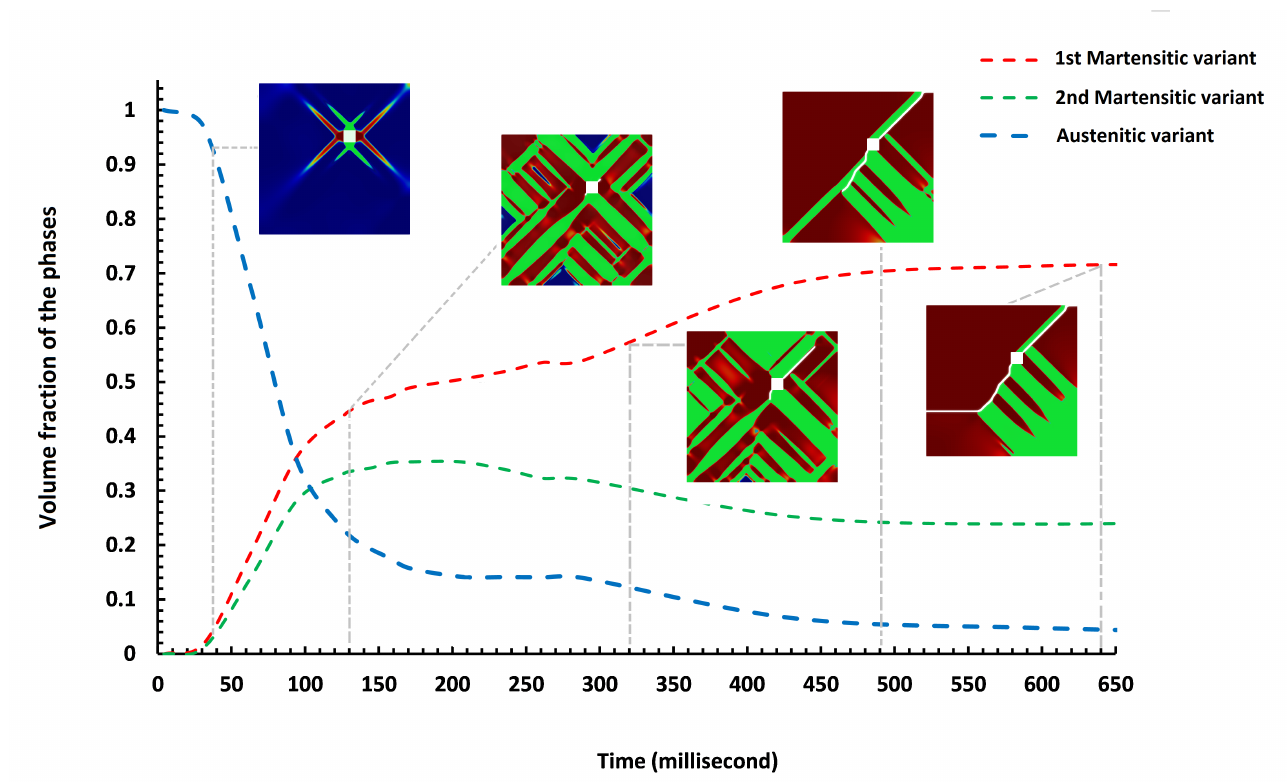
Figure 13. Variation of volume fraction of austenite and martensite phases for the austenitic specimen with a geometric inhomogeneity.